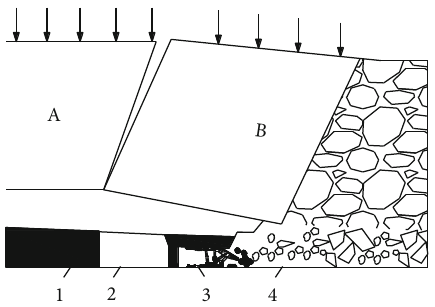
Figure 9: Basic roof breakage characteristics. 1 — coal; 2 — advance direction; 3 — working face; 4 — goaf.